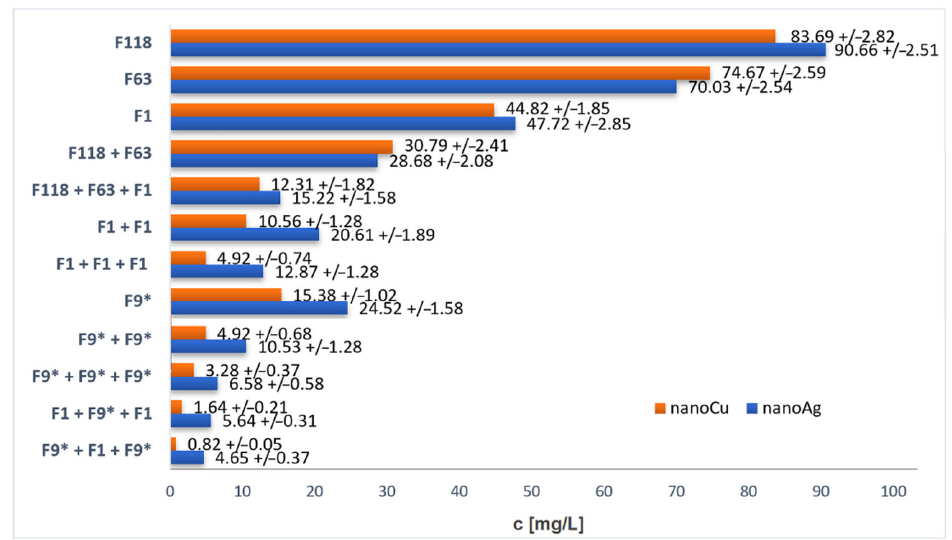
Figure 4. Change in concentration of acceptor fluid after nanoparticle diffusion depending on the filter used.